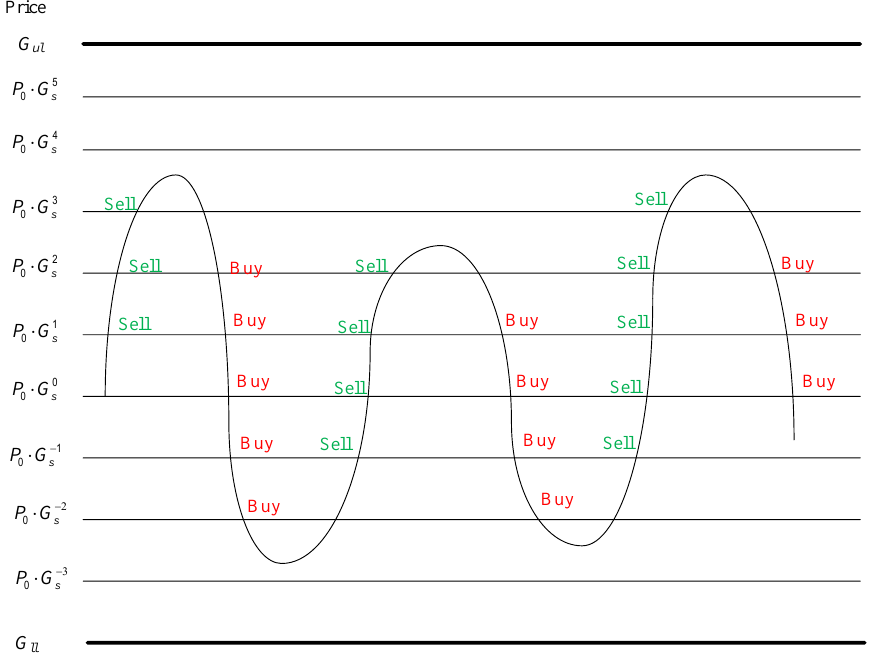
Figure 2. Schematic diagram of equal-ratio grid trading.